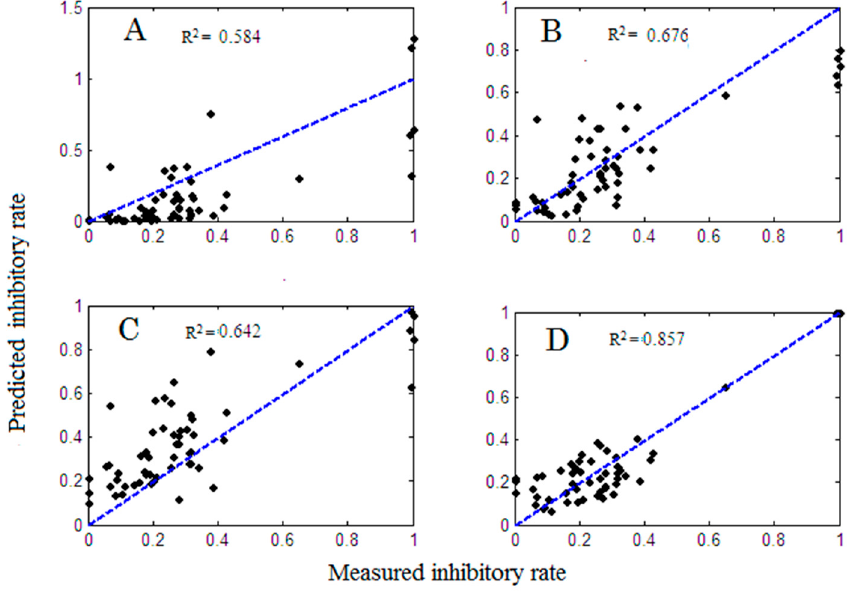
Figure 1. Model adequacy plot of six-standard mixtures by partial least-squares (PLS, A ), concentration addition (CA, B ) model, response addition (RA, C ) model and the Olmstead model ( D ).